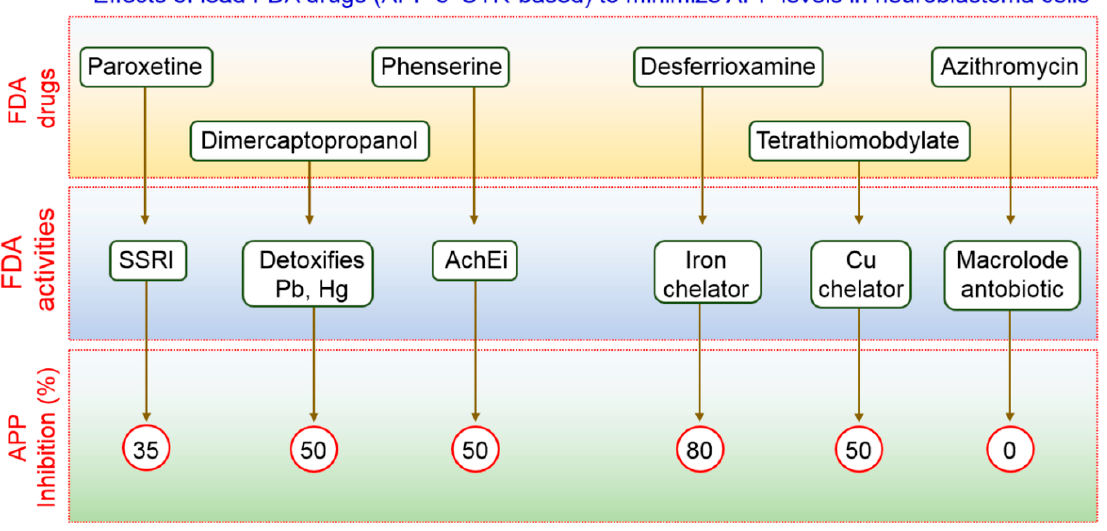
Figure 7. Effects on FDA-approved drugs used for the treatment of AD-associated disorders. The therapeutic action of these FDA-approved compounds has been demonstrated as proof of concept in vivo for selectively reducing APP expression in AD. All the drugs are shown to reduce APP inhibition.